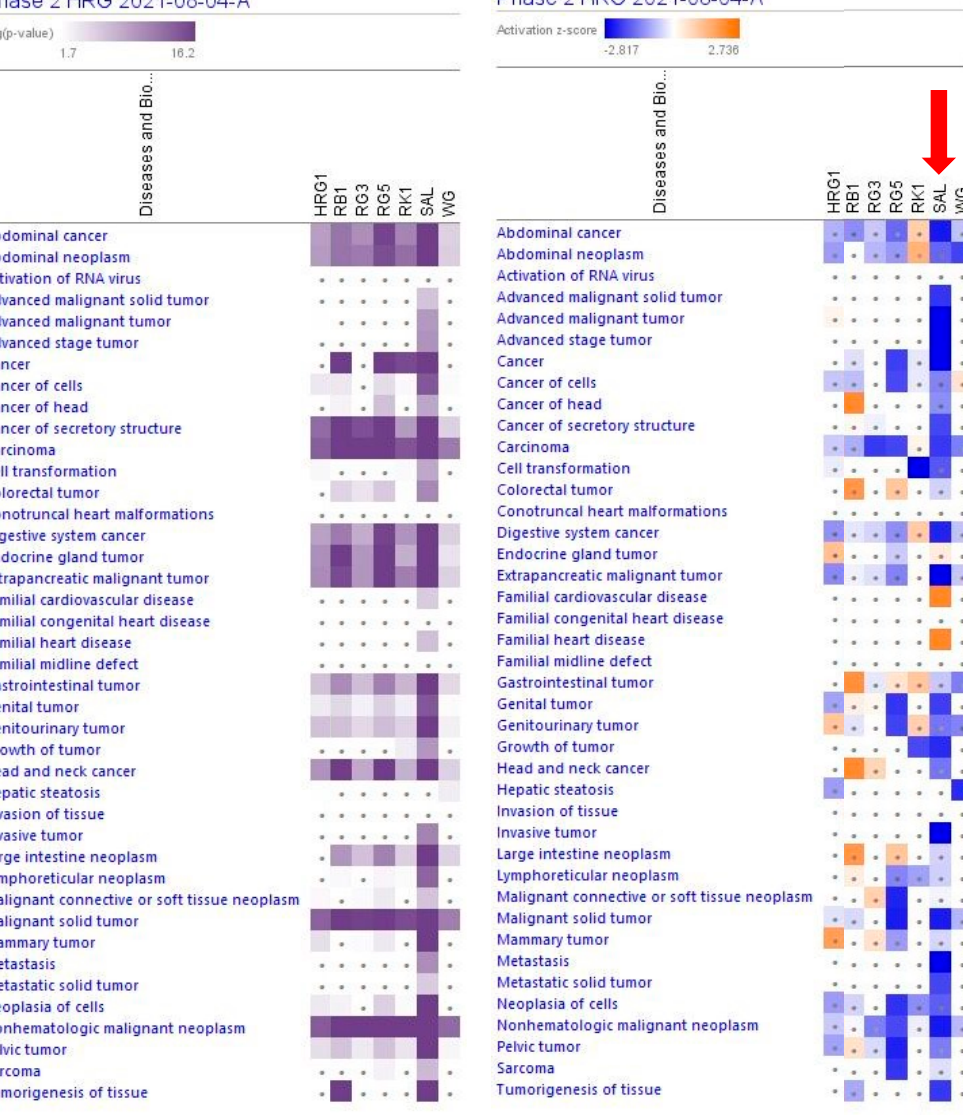
Figure 3. Predicted effects of RG–RS (SAL) at concentrations of 20 µ g/mL, RG at concentrations of 10 µ g/mL (HRG1), white ginseng (WG), and ginsenosides Rb1, Rg3, Rg5, Rk1 at a concentra- tion of 0.1 µ M. The violet color shows the p -value (calculated using a Right-Tailed Fisher’s Exact